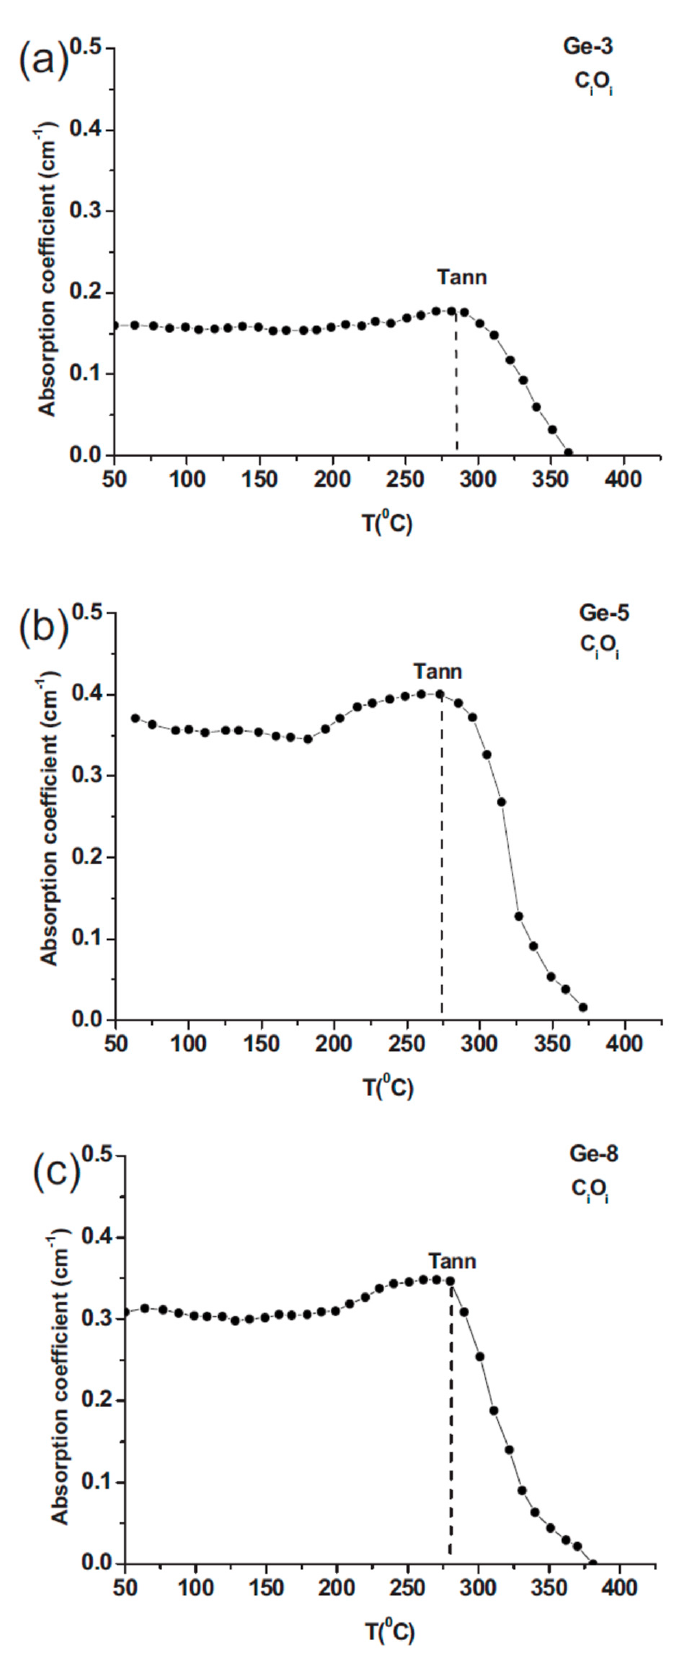
Figure 23. The evolution with T of the C i O i defect as a function of the Ge dopant concentration for the characteristic ( a ) Ge-3, ( b ) Ge-5, and ( c ) Ge-8 samples. Reproduced with permission from [128]. American Institute of Physics,